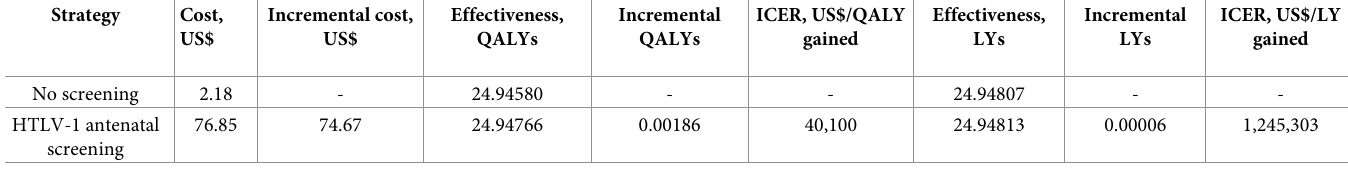
Table 2. Base-case analysis.